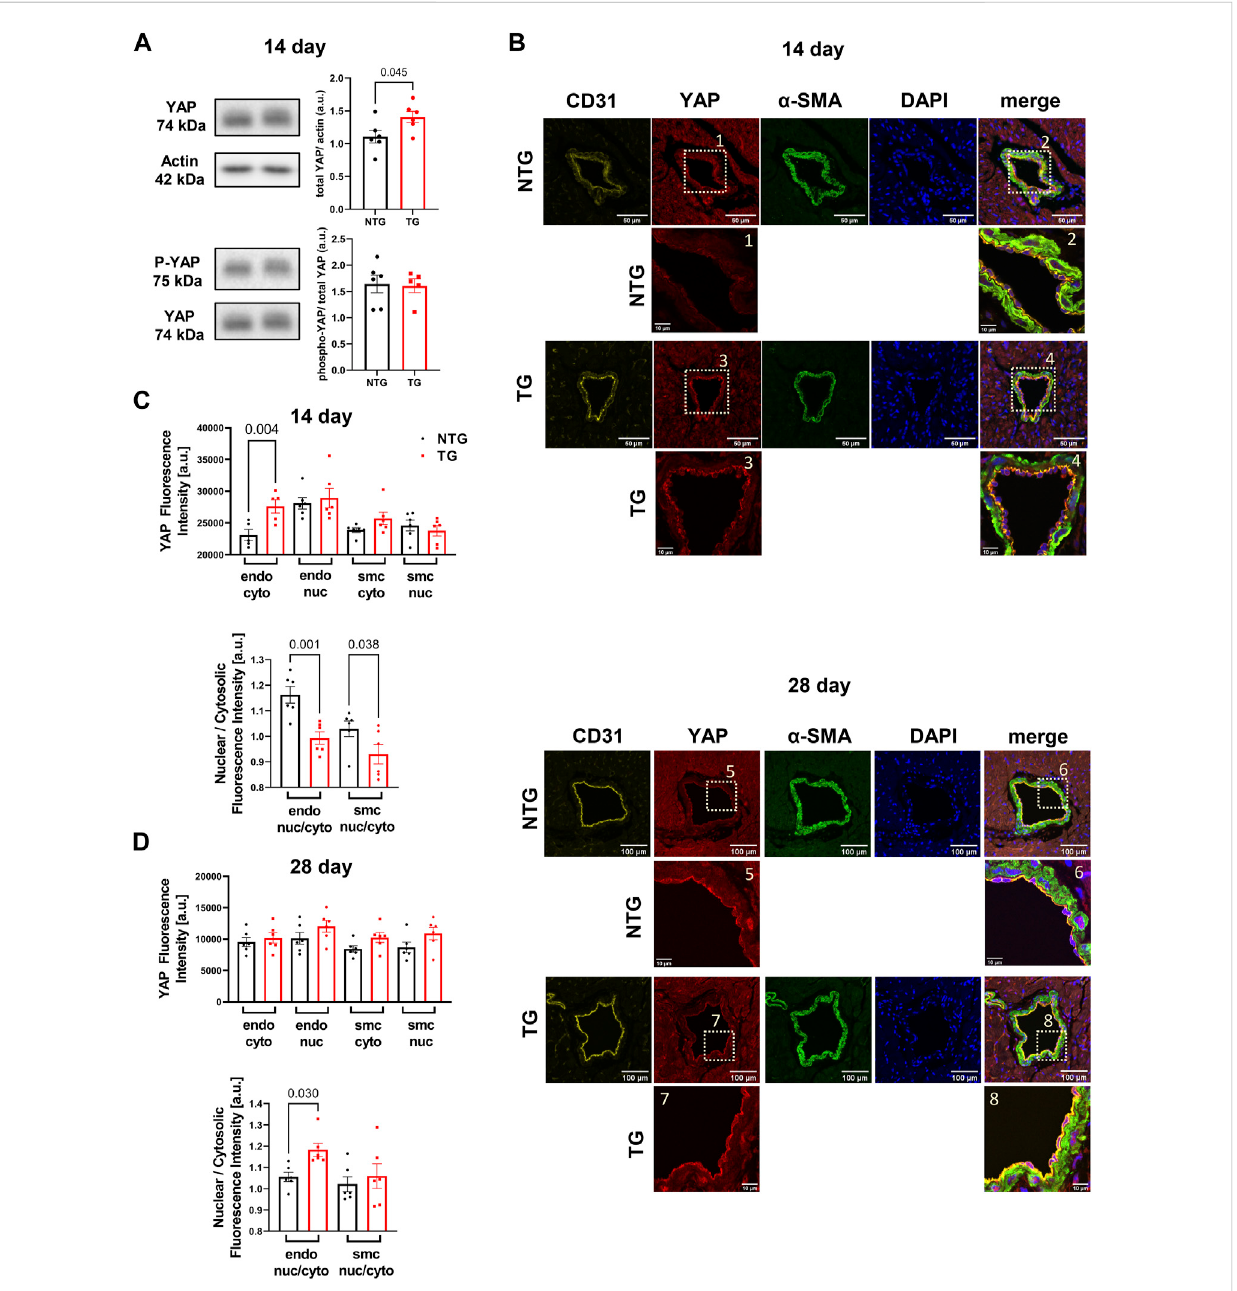
FIGURE 8 Time-dependent expression and localization of YAP. Western blot analysis of YAP abundance (upper panel) and phosphorylation (p-YAP) (Ser-127) (lower panel) at P14 in TG and NTG hearts (A) ; Representative immunohistochemistry (IHC) images of coronary vessels from NTG and TG hearts stained with fl uorescent antibodies against CD31, YAP, α -SMA and DAPI. The merged images represent CD31/YAP/ α -SMA with nuclear DAPI counterstaining of thecoronaryarteryregionatthebasalsectionoftheheartatP14 (B) .InsertsbelowweretakenfromYAPandmergedimagesathighermagni fi cation; Cytosolic and nuclear YAP fl uorescence signal in endothelial (endo) and smooth muscle cells (smc) in the heart sections and a ratio of nuclear/cytosolic YAPexpressionintheendothelialandsmoothmusclecells(smc)intheheartsectionsatP14 (C) ,andP28 (D) .Datapresentedasmean±SEMandanalyzed usingStudent ’ st-test (A) ,NTGN=6,TGN=6andOne-wayANOVAfollowedbyFisher ’ sLSDtest.NTGN=5 – 6,TGN=5 – 6 (C,D) .NTG,non-transgenic; TG,